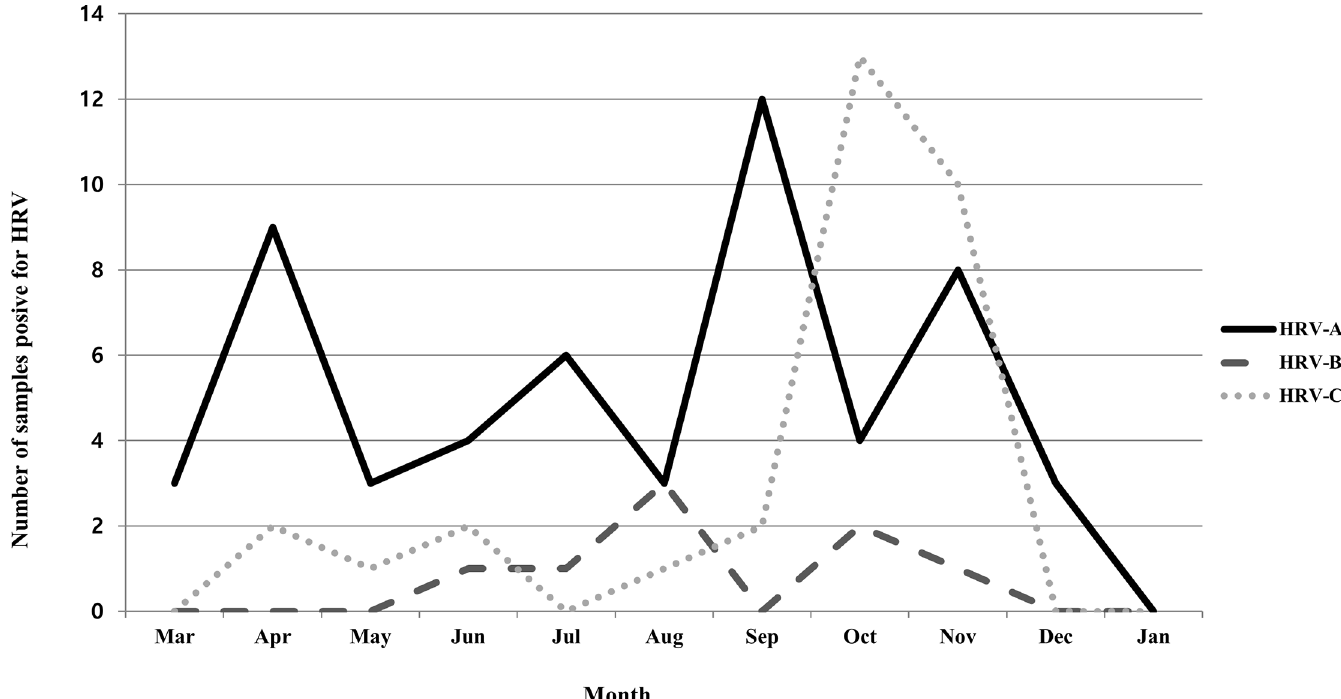
Fig 1. Distribution of three human rhinovirus (HRV) species by month.